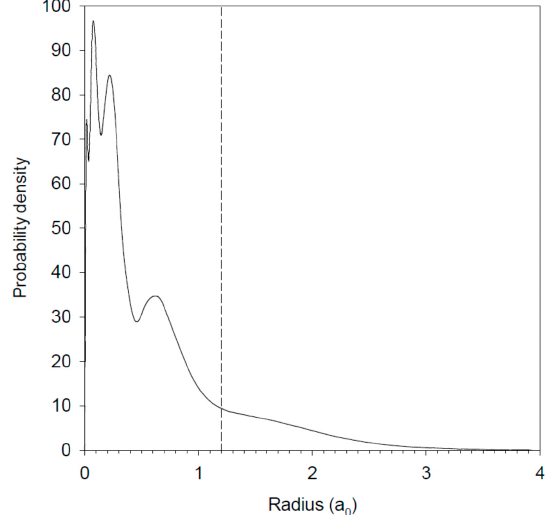
Figure 1. Electron probability density ( P nl 2 ) of the La IV ionic core in the ground configuration (5d6s 2 ) of neutral lanthanum. The value of the cut-off radius used in the HFR+CPOL2 calculations ( r c = 1.20 a 0 ) is also shown in the figure. It represents the distance at which the electron probability density falls to 10 percent of its maximum value, as suggested in [29].